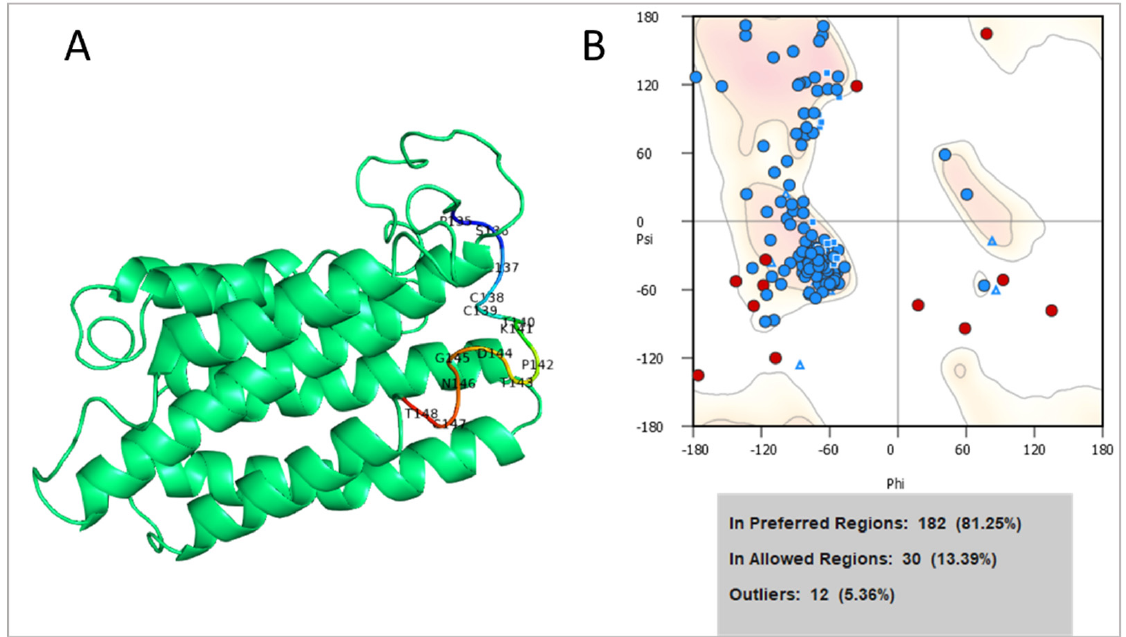
Figure 2. ( A ) Three-dimensional structure of HBsAg of a conserved epitope of HBV-RO-10. The antigenic region used in molecular docking is highlighted in the image; ( B ) Ramachandran plot. Blue dots and triangles represent residues in favored regions and red dots indicates the outliers residues. Images generated by PyMOL©.